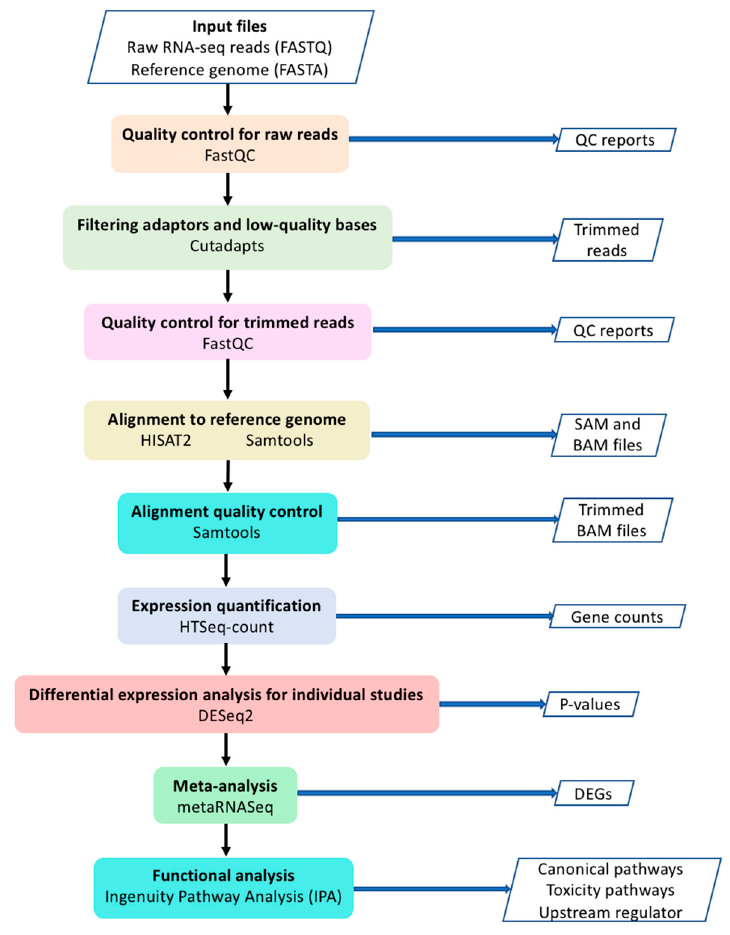
Figure 1. The workflow of the meta-analysis.